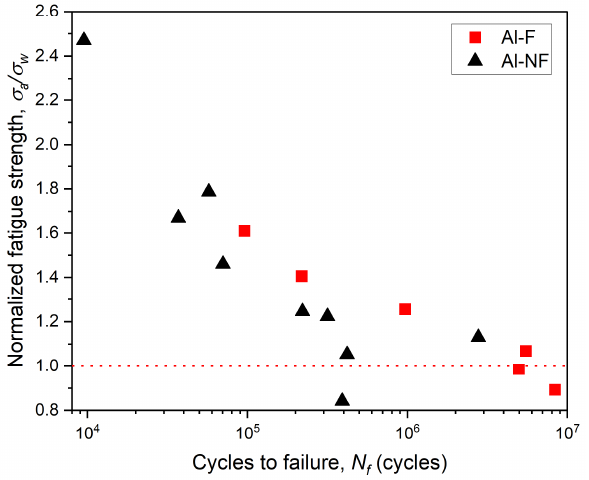
Figure 8. Modified S-N curves using Murakami equation of the Al-NF alloy.